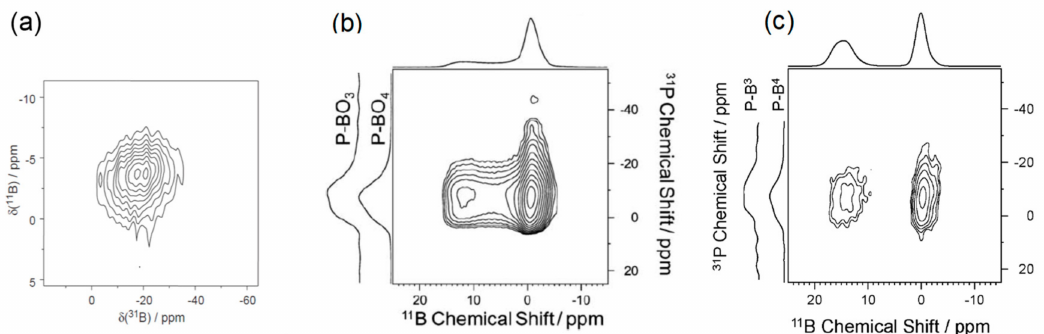
Figure 8. 11 B / 31 P 2D maps obtained on ( a ) sodium borophosphate glass at 9.4 T with the CP-HETCOR sequence, ( b ) lithium borophosphate glass at 9.4 T with the D-HMQC and ( c ) lithium borophosphate glass at 18.8 T with the J-HMQC NMR techniques [19,26,33]. Reprinted with permission from Elsevier and